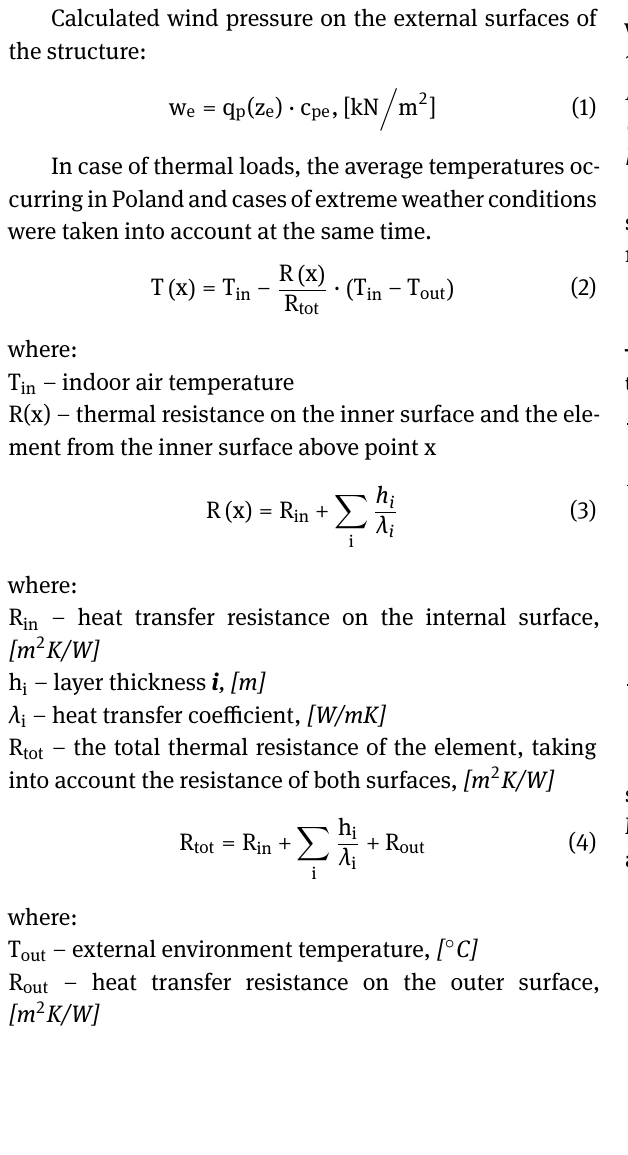
Figure 1: Increase in the value of adhesion stresses depending on the size of the